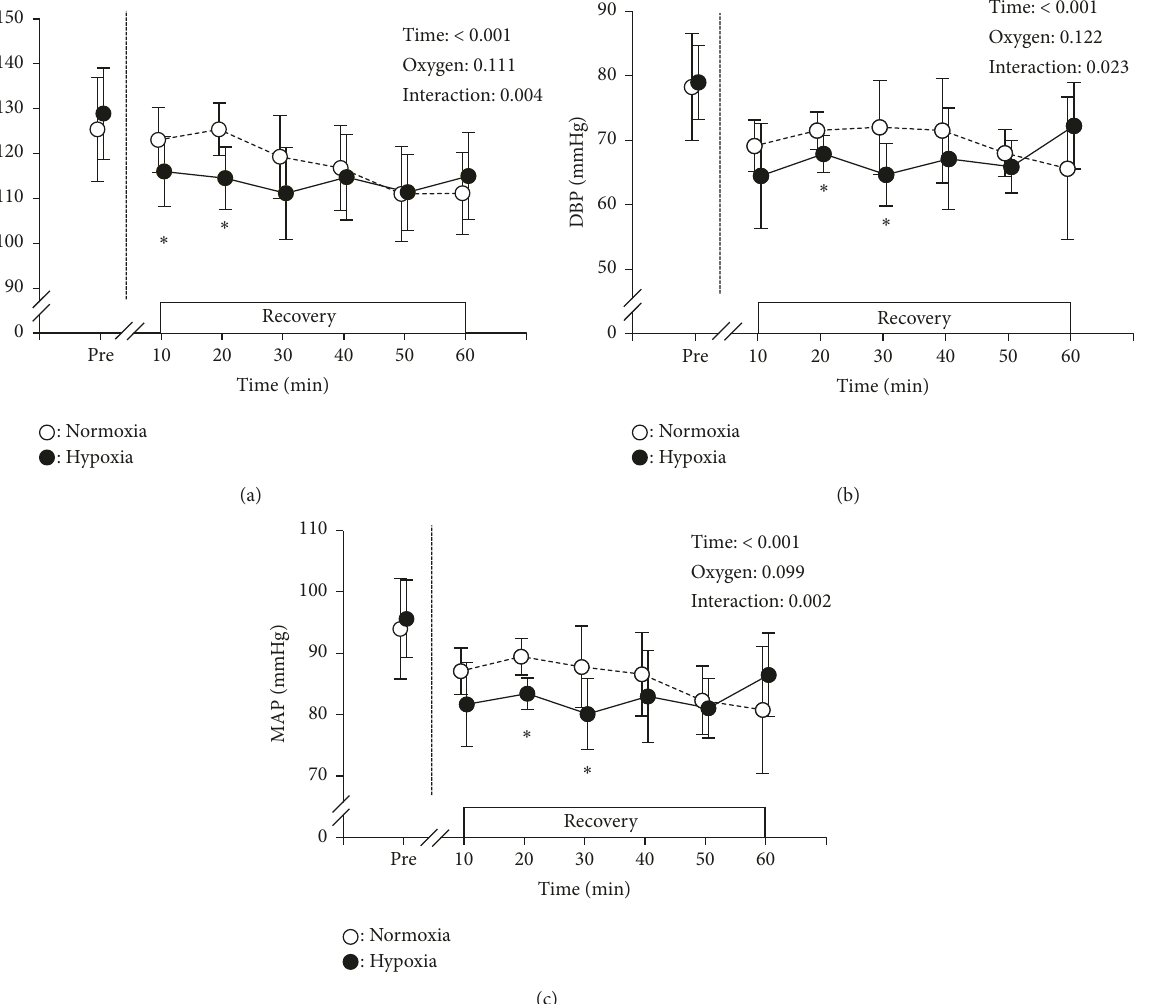
Figure 2: Changes in systolic blood pressure (SBP: panel (a)), diastolic blood pressure (DBP: panel (b)), and mean arterial blood pressure (MAP: panel (c)) at baseline (pre) and during 60 min recovery under normoxia (open circles) and hypoxia (closed circles). ∗ indicates a significant difference between normoxia and hypoxia within the same time